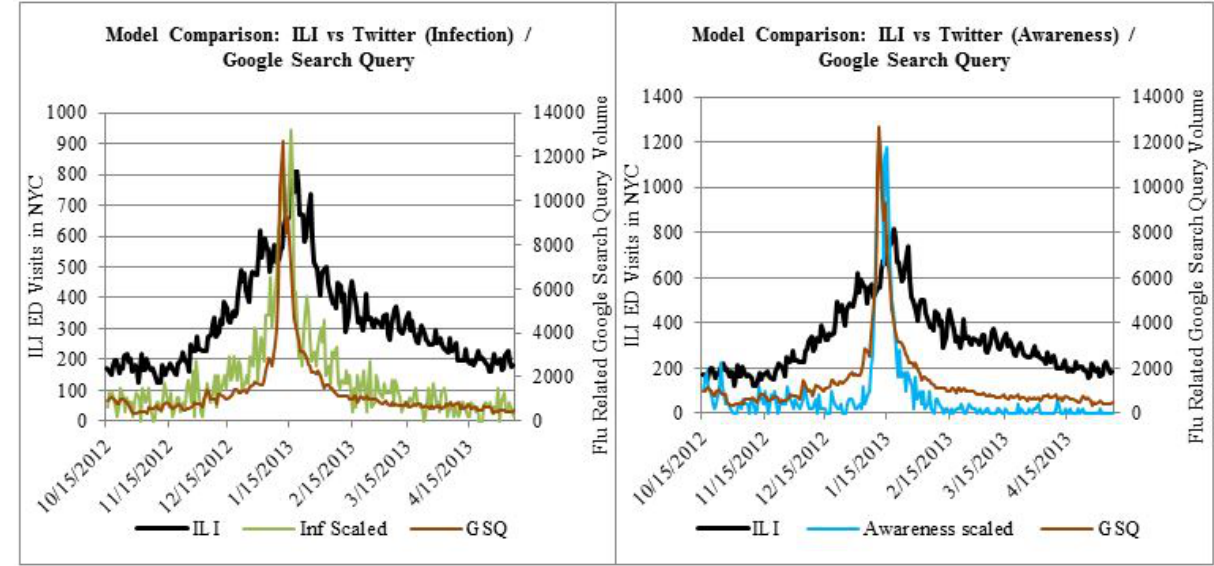
Figure 2. Comparison of Infection tweets and Awareness-based data.